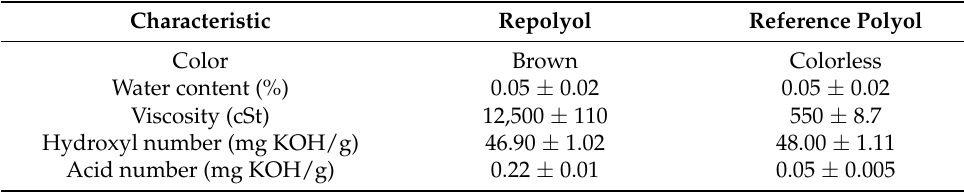
Table 3. Typical physical properties, assessed for the Repolyol and the reference polyol.